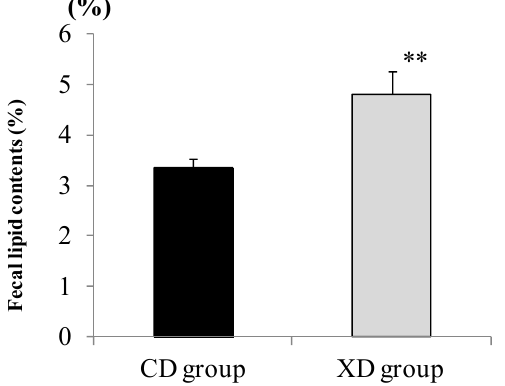
Figure 5. The fecal lipid contents (% dry weight) sampled on the final days of the experiment were significantly greater in the XD group than in the CD group ( p < 0.01) Values are means ± SE ( n = 7). The data were analyzed using the Student’s t -test analysis. ** Significantly different ( p < 0.01) from the CD